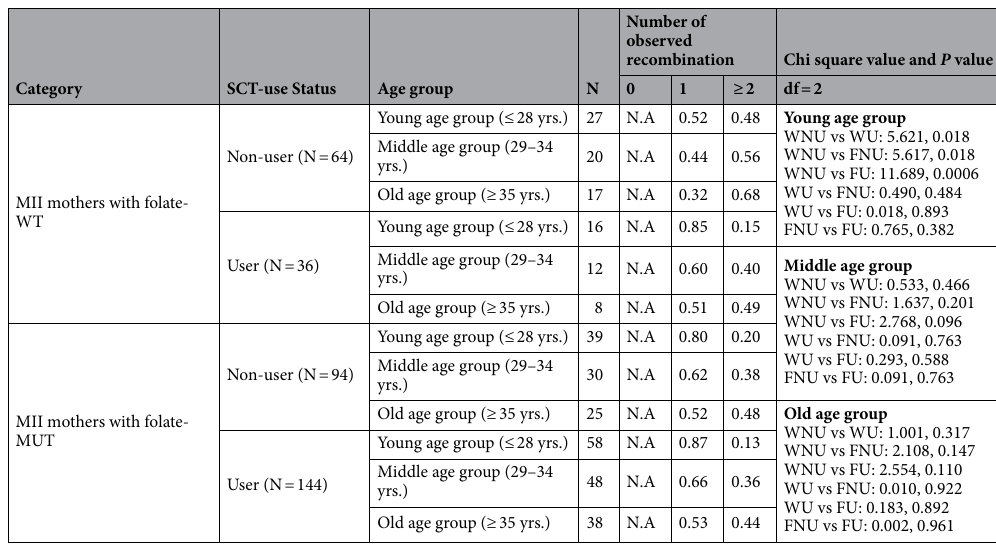
Table 5. Distribution of amount of recombination events among case women stratified by folate regulator genotype, SCT use status and age at conception. Chi-square test for 3 × 2 contingency tables were performed to compare the frequency of amount of recombination events stratified by genotypes, SCT use status and maternal age within MII error group and P value < 0.05 was considered statistically significant. MII Meiosis II, N number of individuals, WNU folate-WT non-user, WU folate-WT user, FNU folate-MUT non-user, FU folate-MUT user, df degrees of